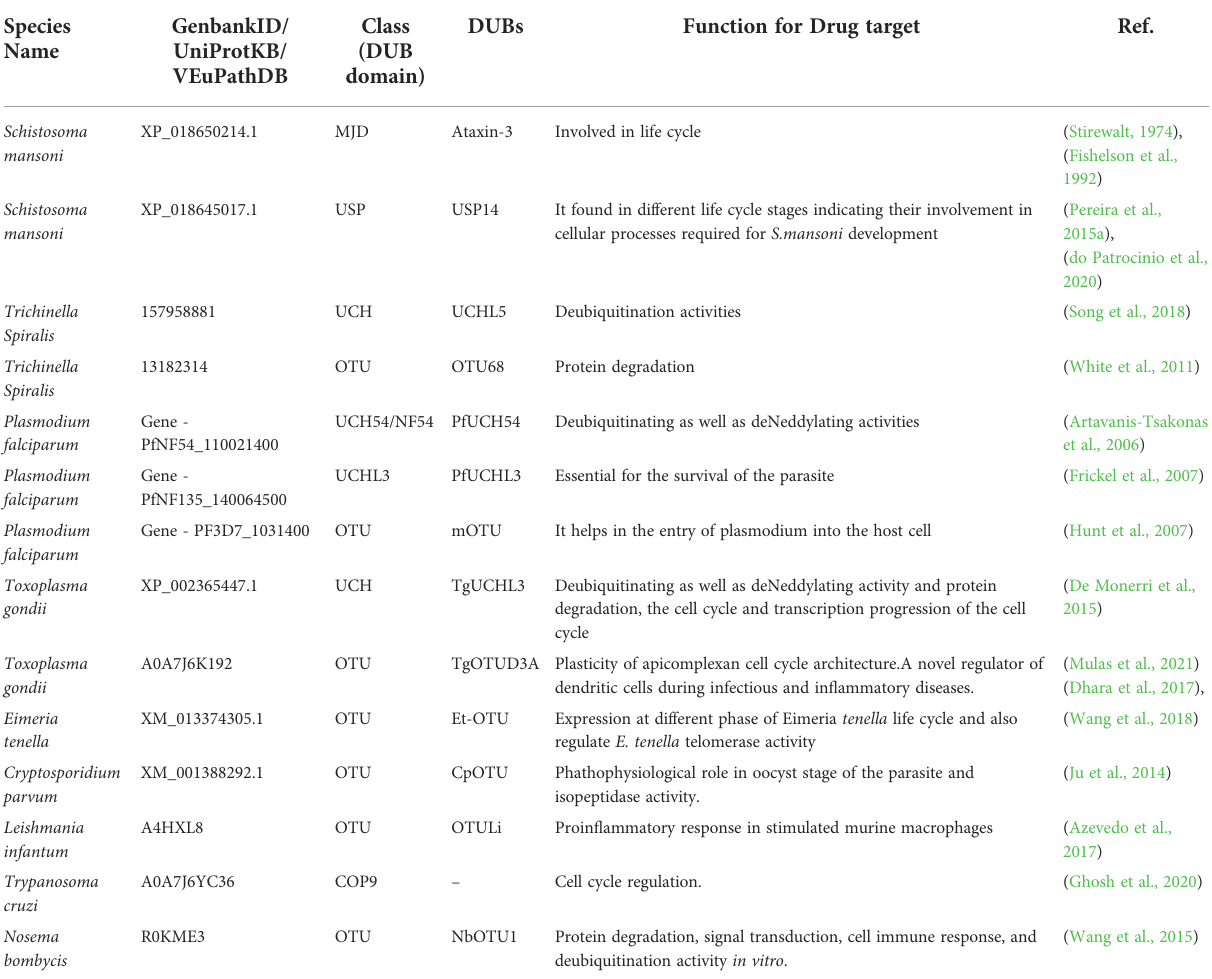
TABLE 1 Functional role of DUBs in different